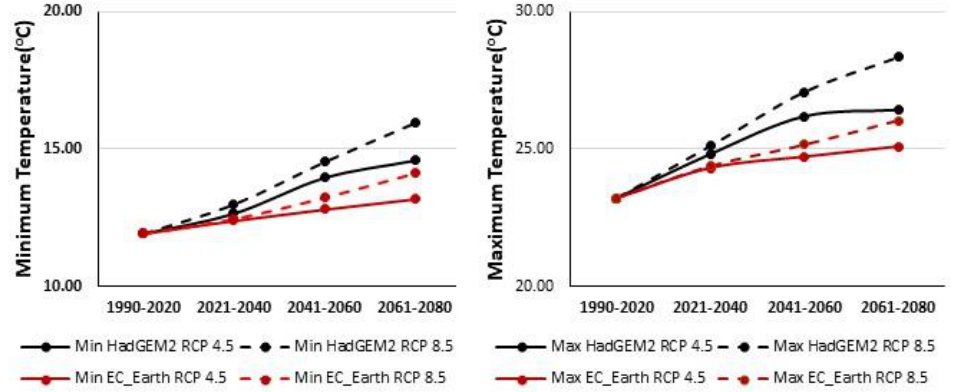
Figure 3. Change in average maximum and minimum temperature for 2021 to 2040, 2041 to 2060, and 2061 to 2080 for climate scenarios RCP 4.5 and RCP 8.5 of GCM models HadGEM2 and EC- Earth.